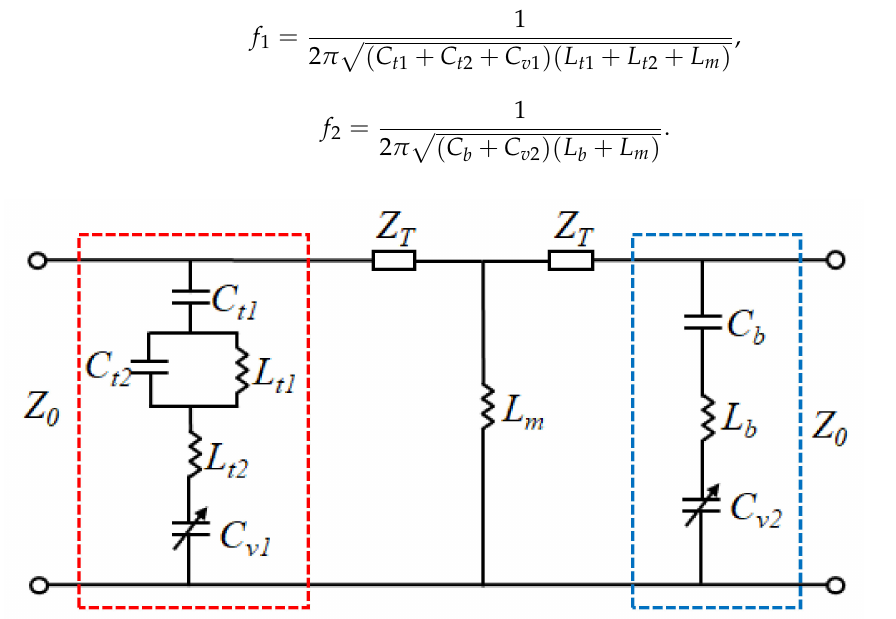
Figure 4. Simplified ECM of the